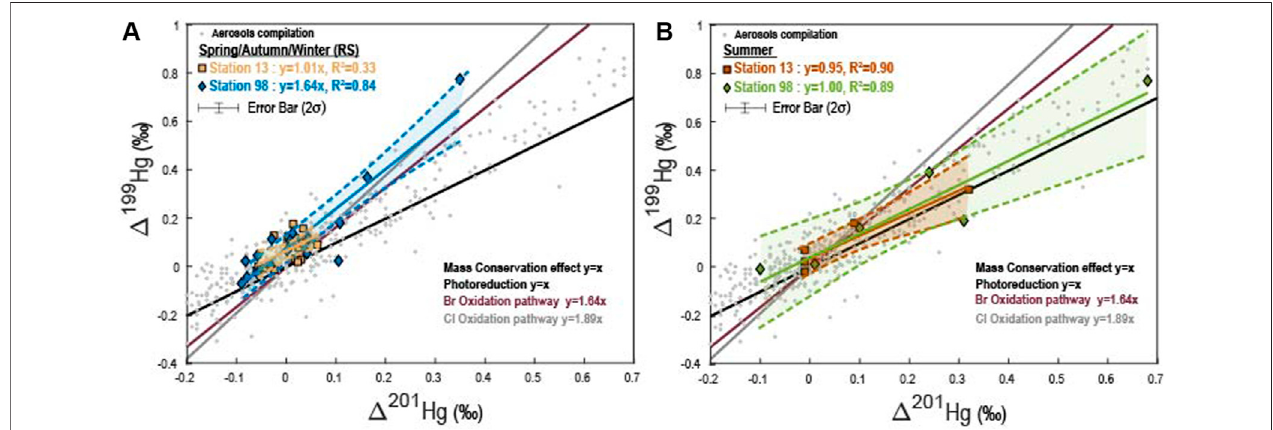
FIGURE 3 | Hg odd-MIF measured in Montreal aerosol samples. (A) Spring Autumn, Winter and (B) Summer. Data from the literature are also reported (Rolison et al., 2013; Huang et al., 2015; Das et al., 2016; Huang et al., 2016; Yu et al., 2016; Xu et al., 2017; Huang et al., 2018; Yuan et al., 2018; Fu et al., 2019; Huang et al., 2019; Xu et al., 2019). Slopes corresponding to Hg oxidation by Br or Cl atoms are taken from Sun et al. (2016). Slope for the photoreduction is from Bergquist et al. (2007), and that corresponding to the mass conservation effect is detailed in the Supplementary Materials